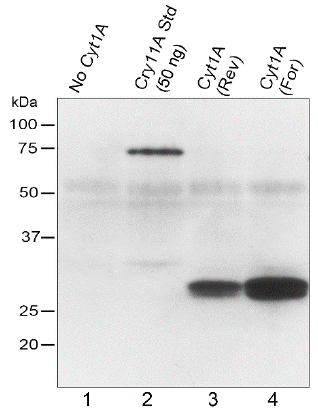
Figure 2. Western blot analysis of CC-373 transformants. 20 µg of total protein was loaded in each lane of the 10% polyacrylamide gel, which was electroblotted to PVDF and probed with an anti-FLAG antibody. The positions and sizes of protein markers are shown to the left. Lanes: No Cyt1A, total protein from a CC-373 transformant that did not have the psbD m : cyt1Aa : psbA gene; Cry11Aa Std (50 ng), same protein as in the “No Cyt1A” lane plus 50 ng of purified FLAG-tagged Cry11Aa as standard; Cyt1A (Rev), protein from a CC-373 transformant homoplasmic for the Reverse psbD m : cyt1Aa : psbA gene; Cyt1A (For), protein from a CC-373 transformant homoplasmic for the Forward psbD m : cyt1Aa : psbA gene.